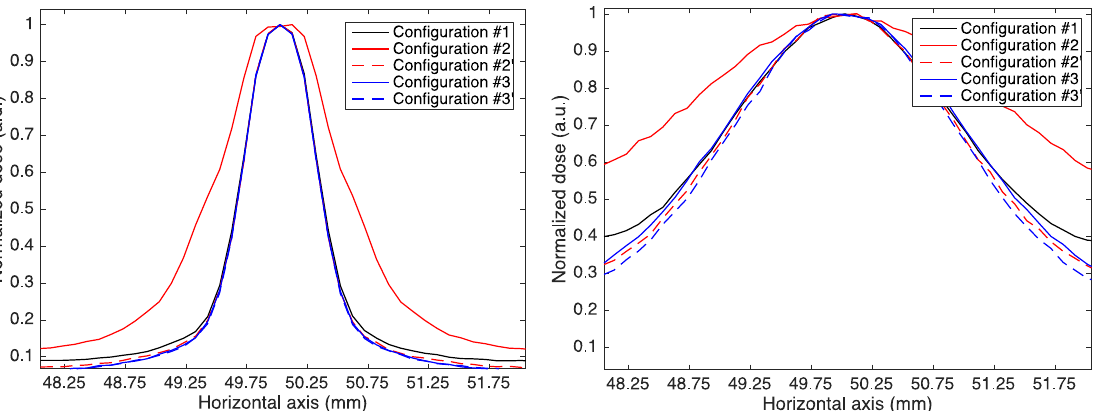
Figure 3. Transverse profile of the central minibeam for 150 MeV protons at the entrance of the water phantom and at a 7 cm